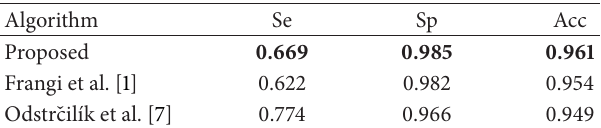
Table 4: Overall sensitivity (Se), specificity (Sp), and accuracy (Acc) measured using our high resolution fundus database.